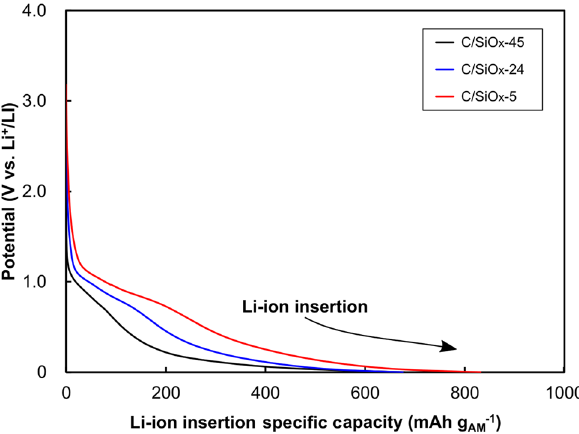
Figure 3. Li-ion insertion profiles of the C/SiO x active materials during pre-lithiation.